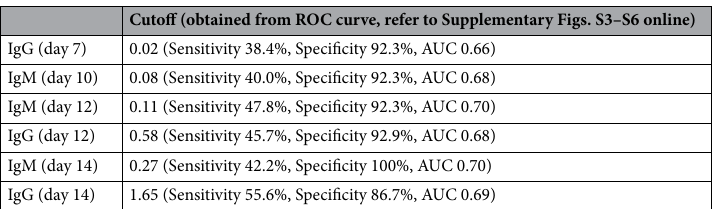
Table 2. Cutoff values of the antibody levels. Ig immunoglobulin, ROC receiver operating characteristic, AUC area under the concentration–time curve.